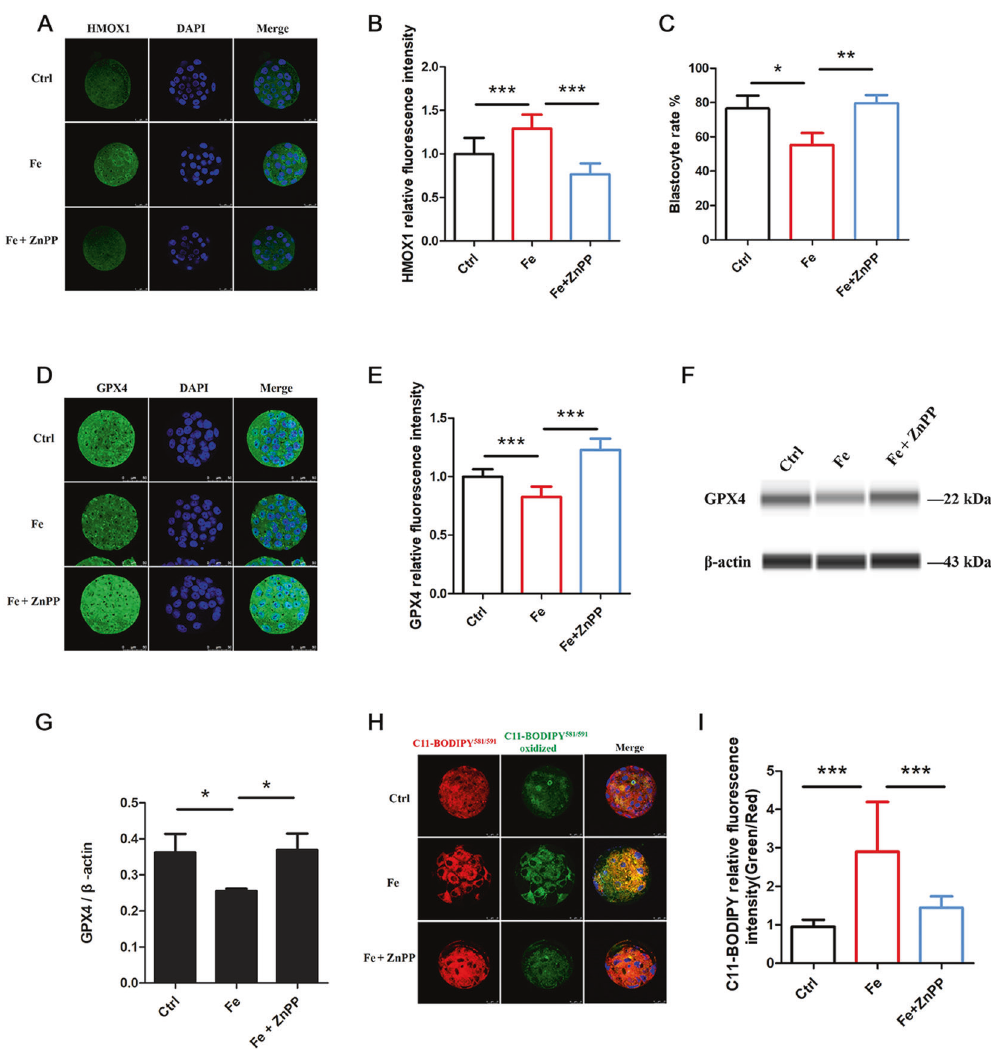
Fig. 6 HMOX1 is essential for iron overload induced embryo ferroptosis. A Representative immunostaining for HMOX1 in mouse embryos treated with 100 μ M Fe and 100 μ M Fe + 10 μ M ZnPP. Nuclei were stained blue with DAPI, the scale bar = 25 μ m. B Relative fl uorescence intensity statistics of HMOX1 in the control ( n = 14), Fe ( n = 14) and Fe + ZnPP ( n = 12). Data are expressed as mean ± SD. *** P < 0.001. C The blastocyst rate of mouse embryos cultured with 100 μ M Fe and 100 μ M Fe + 10 μ M ZnPP. * P < 0.05, ** P < 0.01. D Representative immunostaining for GPX4 in mouse embryos treated with Fe and Fe + ZnPP. Nuclei were stained blue with DAPI, the scale bar = 50 μ m. E Relative fl uorescence intensity statistics of GPX4 in the control ( n = 16), Fe ( n = 15) and Fe + ZnPP ( n = 18). Data are expressed as mean ± SD. *** P < 0.001. F Simple western immunoblots showed GPX4 expression in mouse embryos from control, Fe and Fe + ZnPP. β -actin is shown as loading control. G Quanti fi cation analysis of GPX4 expression in embryos from each treatment, ( n = 3). Data are expressed as mean ± SD. * P < 0.05. H The lipid peroxidation stained by BODIPY 581/591 C11 in mouse embryo cultured with Fe and Fe + ZnPP. Red representing non- oxidized BODIPY 581/591 C11, green representing oxidized BODIPY 581/591 C11, the scale bar = 25 μ m. I Relative fl uorescence intensity statistics of BODIPY 581/591 oxidation (Green/Red) in control ( n = 24), Fe ( n = 25), and Fe + ZnPP ( n = 24). Data are expressed as mean ± SD. *** P <